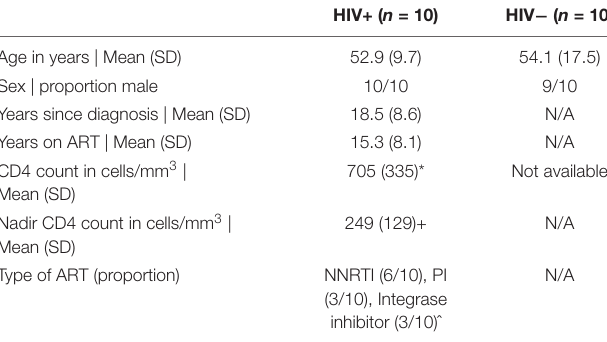
TABLE 1 | Demographic information of HIV